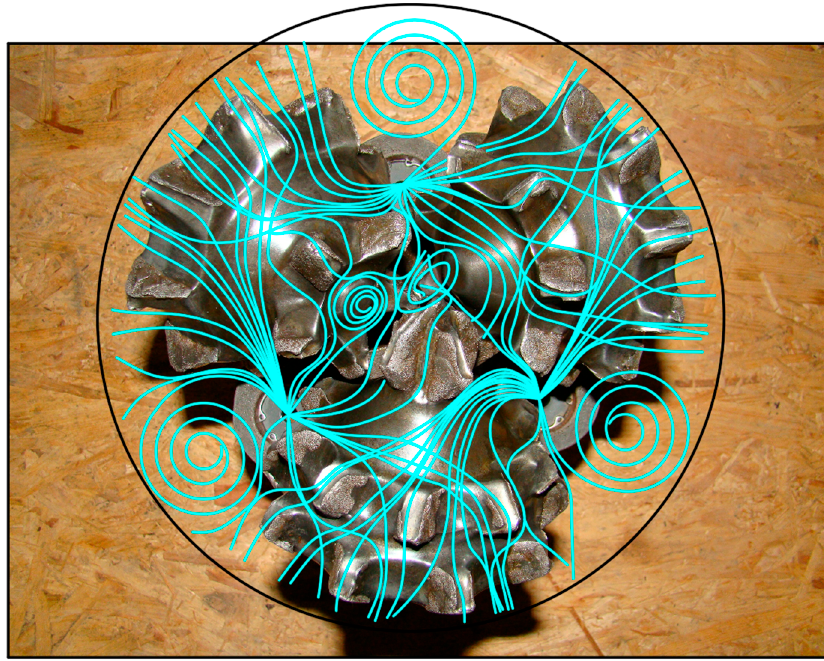
Figure 3. Simplified sketch of the movement of the drilling fluid in the area of the rollers. Protection against excessive wear of the teeth is provided, for example, by a carbide coating, which in our case was welded on the parts of the teeth that are more exposed to friction, temperature and